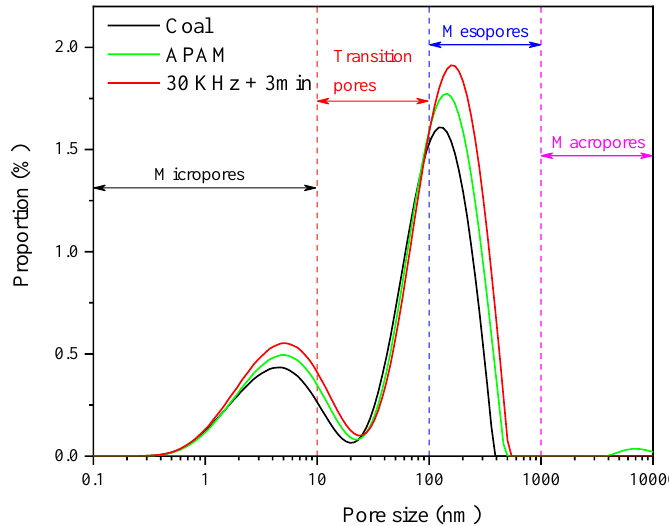
Figure 15. Distribution of the pore size of the filter cake under different conditions.